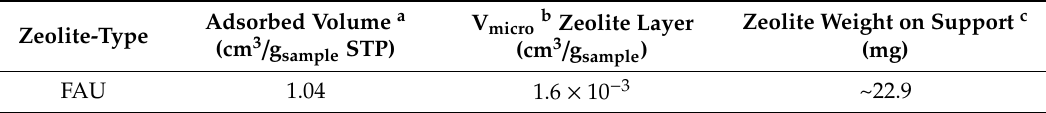
Table 1. The results of N 2 physisorption of the zeolite layers obtained on treated macroporous α -Al 2 O 3 supports, after 24 h of synthesis at the heating temperature at 75 ◦